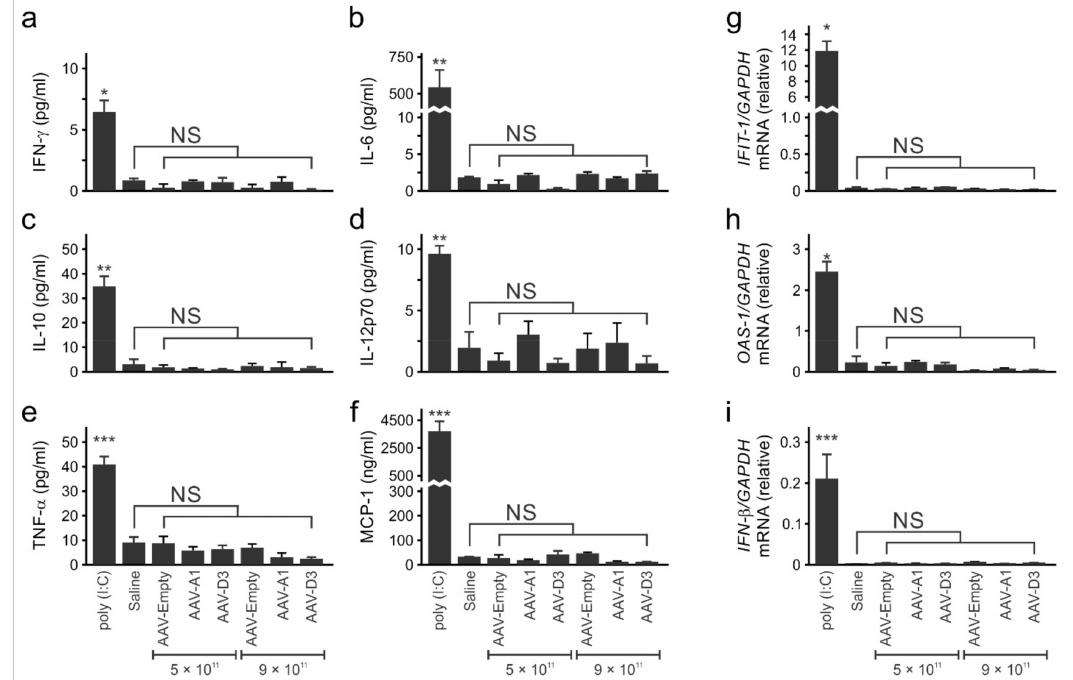
Figure 2. Quantification of cytokines and immune response gene expression in mice after injection with AAVs. Protein levels of ( a ), interferon gamma (IFN- γ ), ( b ), interleukin 6 (IL-6), ( c ), interleukin 10 (IL-10), ( d ), interleukin 12p70 (IL-12p70), ( e ), tumour necrosis factor alpha (TNF- α ) and ( f ), chemoattractant protein 1 (MCP-1) 6 h post-injection of AAVs, Poly (I: C) or saline. ( g – i ), Oligoadenylate synthase 1 ( OAS-1) , interferon beta ( IFN- β ) and IFN-induced protein with tetratricopeptide repeats